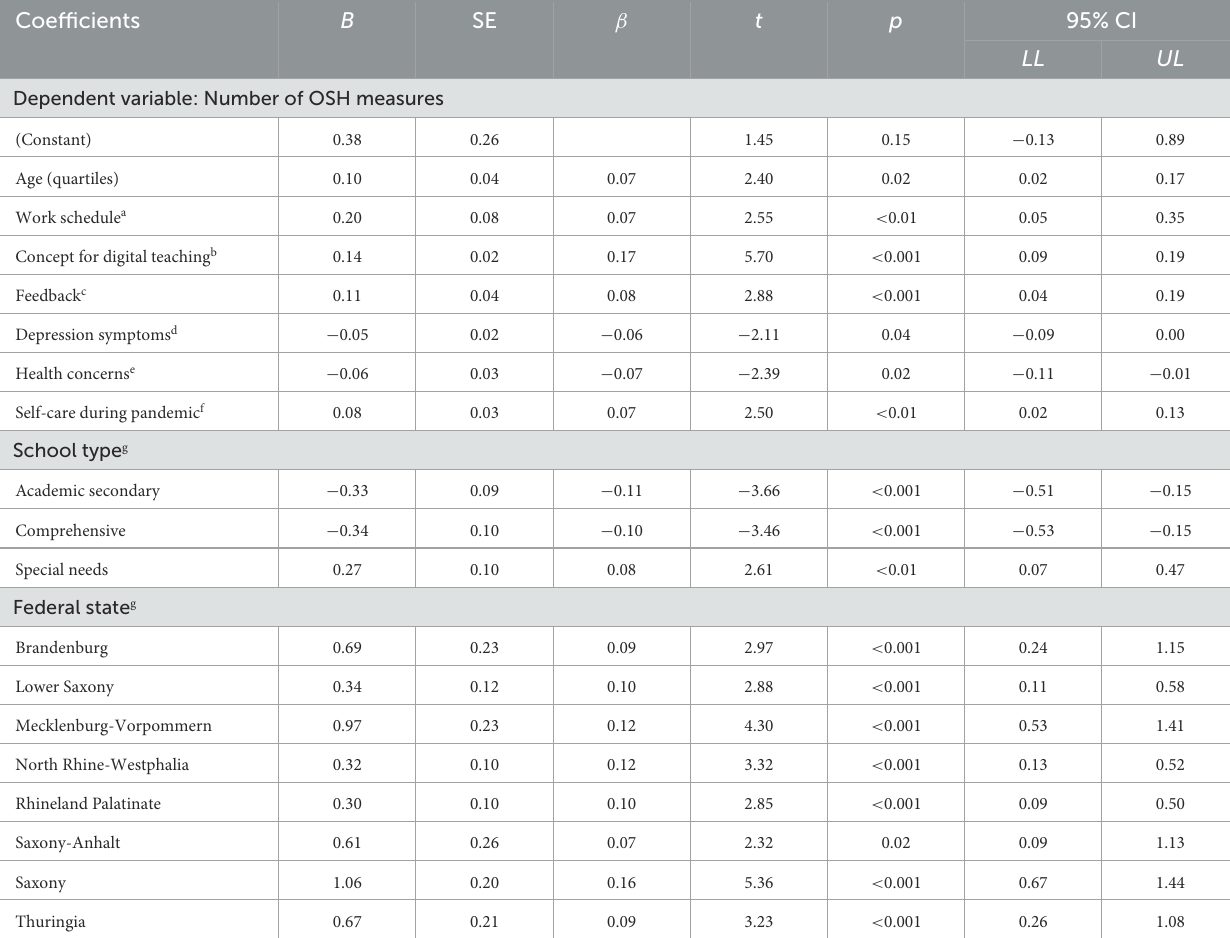
TABLE 3 Significant predictors of occupational safety and health